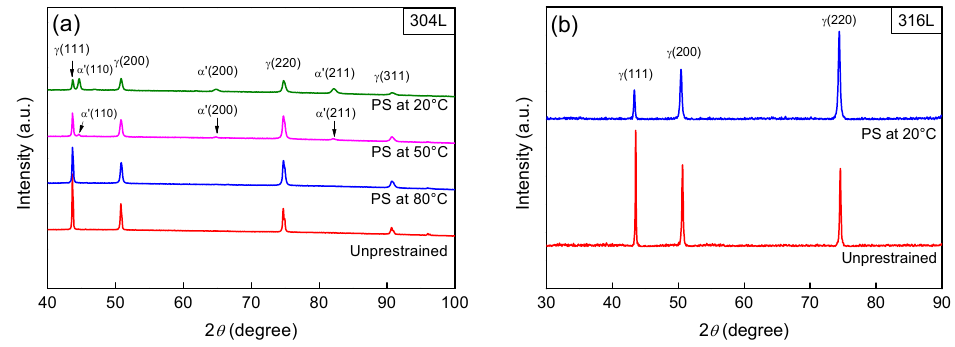
Figure 2. XRD patterns of 304L ( a ) and 316L ( b ) steel specimens un ‐ prestrained and prestrained (PS) to 30% strain at different temperatures. The (220) γ reflection becomes dominant after prestraining, indicating that texture changes also occur due to the uniaxial tensile prestrain.